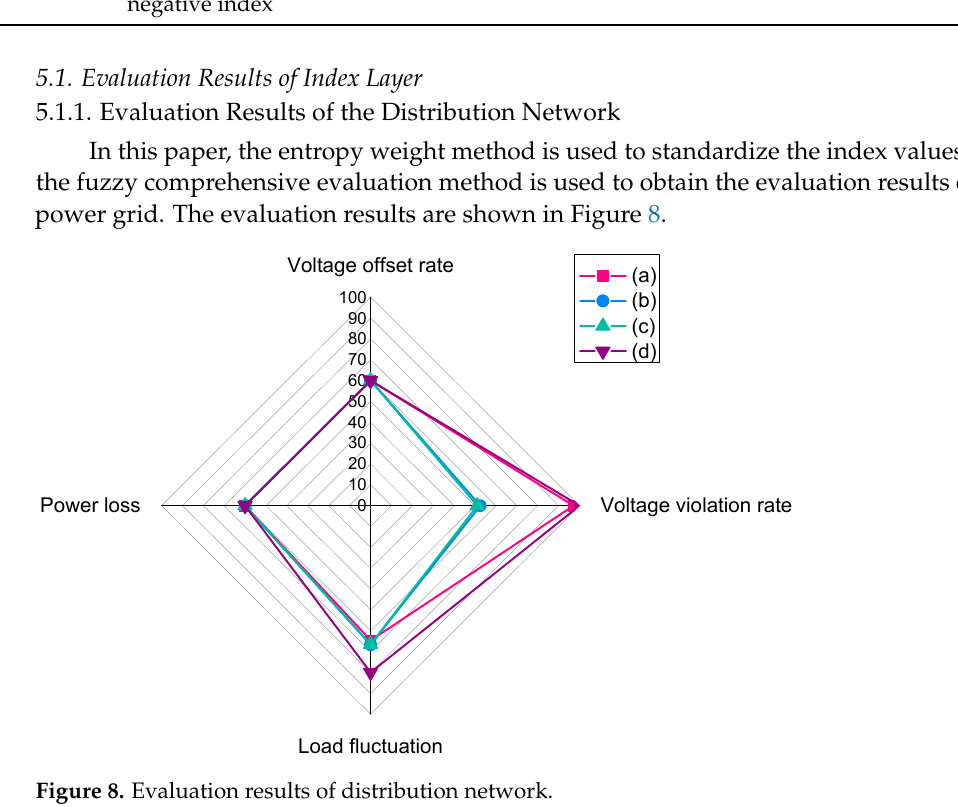
Figure 9. Evaluation results of road network. When strategy (d) is applied to guide users, there are obvious disadvantages in link travel time compared with the other three guidance strategies. Because EVs are guided to a single FCS, the travel time of some links is increased. Due to the diversion e ff ect of cen- tralized guidance, there is no signi fi cant impact on the overall service level and road fl ow of the road network. Strategy (b) and strategy (c) have the least impact on the road net- work operation, so these two strategies have almost the same score. When strategy (a) is applied to guide EVs, the scoring result is basically consistent with strategy (b) and strat- egy (c).